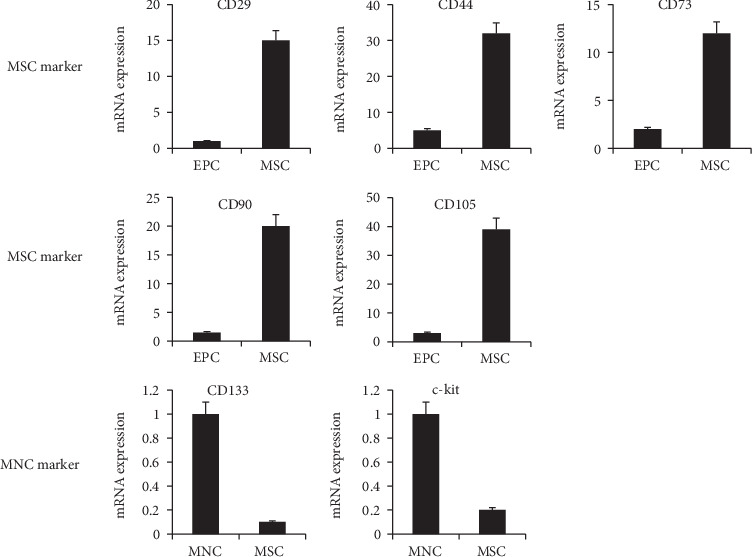
Characterization of CD marker profile of MCSs derived from human umbilical cord blood (hUCB-MSCs) of the normal group (n = 20) by RT-qPCR. hUCB-MSCs were positive for the expression of CD29, CD44, CD73, CD90, and CD105 but negative for CD133 and c-kit.